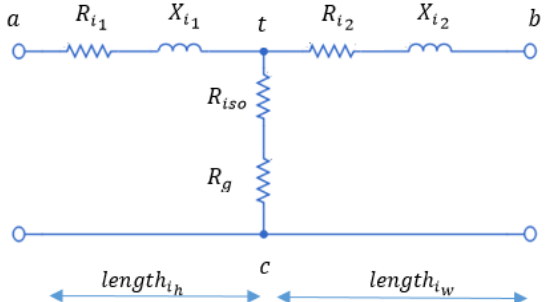
Figure 2. Model of a line having a damaged cable insulation [14].